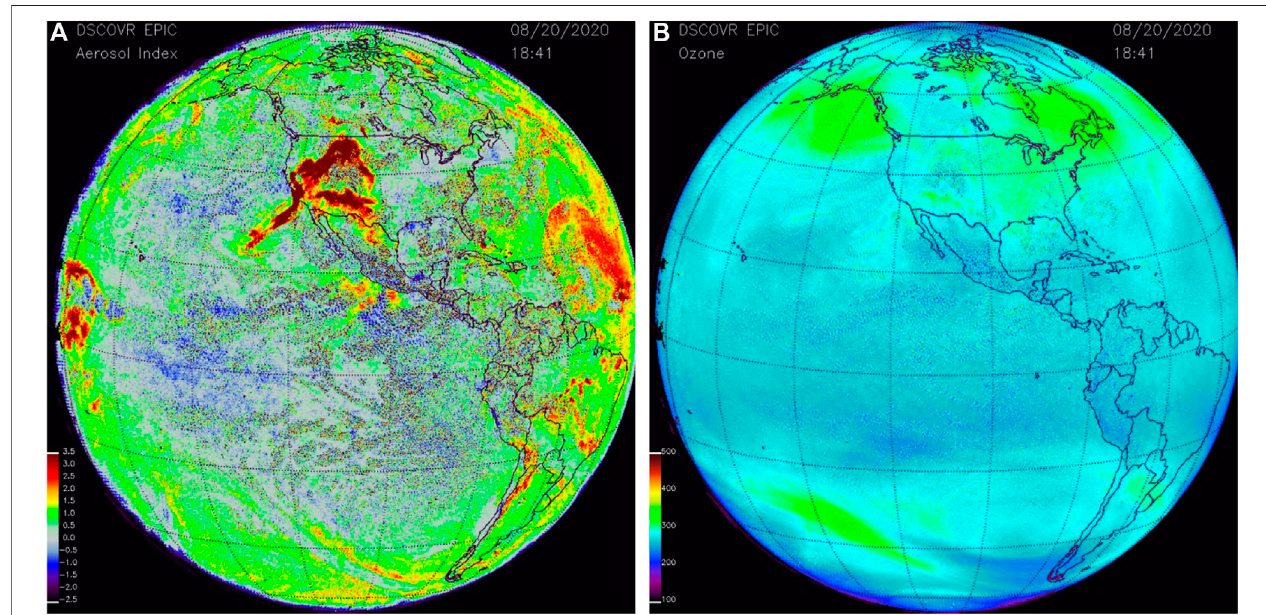
FIGURE 1 | EPIC synoptic maps of the aerosol index (A) and TOZ (B) on August 8, 2020, at 18:41 UTC. Elevated levels of aerosols (AI > 5) are clearly seen over western United States from massive wild fi res. The ozone algorithm ’ s linear spectral dependence of re fl ectivity provides effective corrections for aerosol contamination. The corrected ozone fi elds are smooth without any apparent arti fi cial structures imposed by wild fi res. Ozone averaged over the aerosol contaminated area agrees well with the surrounding area.